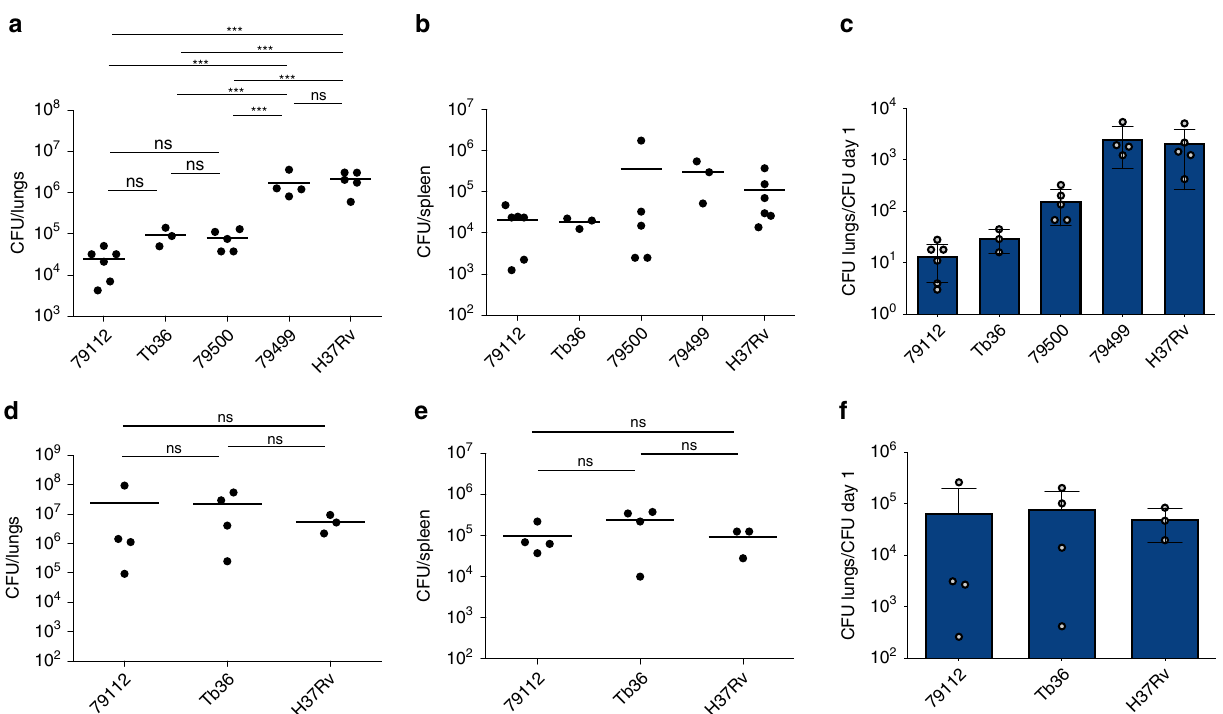
Fig. 2 Virulence pro fi les of selected Indian Mtb WT strains in different in vivo models. a – c In vivo growth pro fi les of TbD1-intact and Δ TbD1 Mtb strains in the guinea pig infection model. Guinea pigs were aerosol-challenged with different Indian strains or the laboratory reference strain H37Rv. Eight weeks after infection, the bacterial load in lungs ( a ) and spleen ( b ) was determined. Statistical differences in CFU values obtained in organs from animals infected with different Mtb strains were determined by the univariate analysis of variance test followed by Sidak post-hoc test (*** P < 0.001; ns: not signi fi cant). c CFU ratio (CFU at day 56/CFU at day 1) obtained in lungs of animals infected with Mtb Indian strains and the H37Rv control strain. d – f . Virulence potential of ancestral Mtb strains (79112, Tb36) in the mouse model in comparison with H37Rv. Groups of four C57BL/6 mice were aerosol infected with different Mtb strains, to obtain an infection dose of 100 – 500 CFU/lungs. Four weeks after infection, the bacterial load in lungs ( d ) and spleen ( e ) of Mtb-infected animals was determined. Statistical signi fi cance of differences in CFU numbers was determined by one-way Anova test followed by Bonferroni post hoc test (ns: not signi fi cant). f CFU ratio (CFU at day 30/CFU at day 1) obtained in lungs of animals infected with TbD1-positive strains and the H37Rv control strain. The fi gure depicts single data points, mean, and standard deviation of CFU numbers or CFU ratio values obtained in representative guinea pig ( a – c ) and mouse ( d – f ) infection